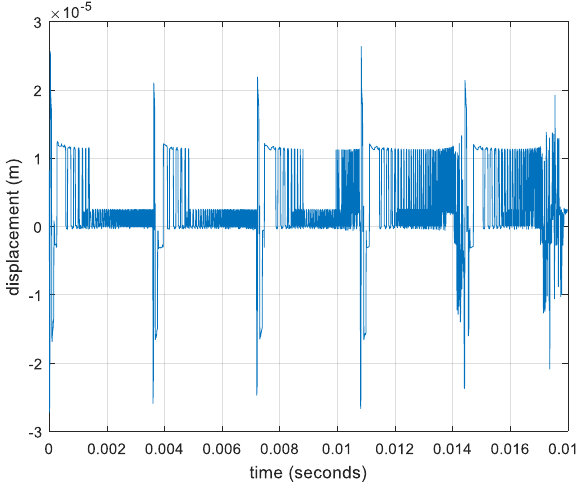
Figure 14. Vibration in time domain (healthy machine).